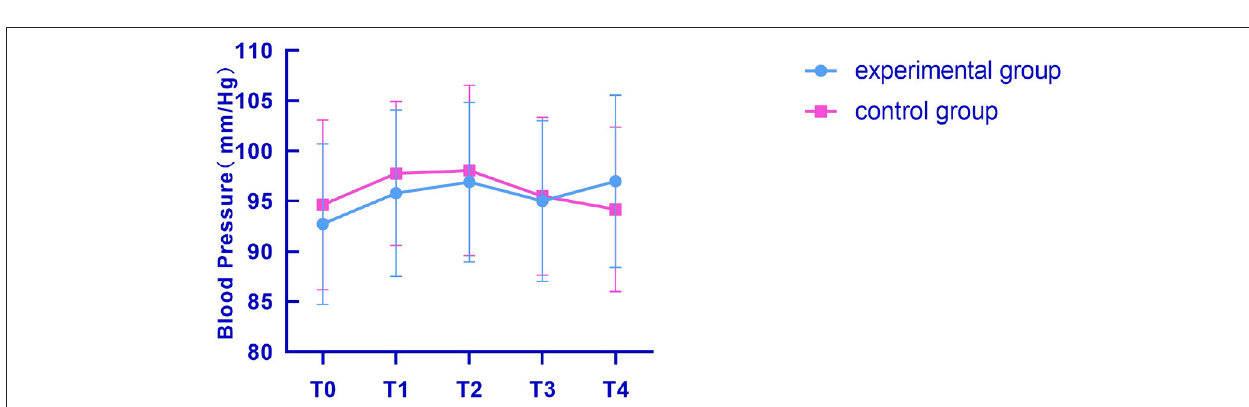
FIGURE 5 | Comparison of arterial blood pressure changes between the two groups at different times. The x -coordinates T0, T1, T2, T3, and T4, respectively, represent 1h, 1, 2, 3, and 4 d after puncture, and the y -coordinate represents the arterial blood pressure measured in the two groups of patients. The figure indicated that the blood pressure of the two groups was not significantly different 1h after puncture. The experimental group was 92.73 ± 7.99, and the control group was 94.63 ± 8.45 ( t = 0.89, P = 0.37). One day after puncture, there was no significant difference in blood pressure between the two groups: 95.79 ± 8.26 in the experimental group and 97.77 ± 7.15 in the control group ( t = 0.99, P = 0.33). There was no significant difference in blood pressure between the two groups 2 d after puncture: 96.91 ± 7.94 in the experimental group and 98.06 ± 8.47 in the control group ( t = 0.54, P = 0.59). There was no significant difference in blood pressure between the two groups 3 d after puncture. The difference was not statistically significant between the experimental group (95.01 ± 8.00) and the control group (95.49 ± 7.84) ( t = 0.23, P = 0.82). There was no significant difference in blood pressure between the two groups 4 d after puncture, indicating that there was no statistical significance between the experimental group (96.98 ± 8.57) and the control group (94.18 ± 8.17) ( t = 1.29, P =